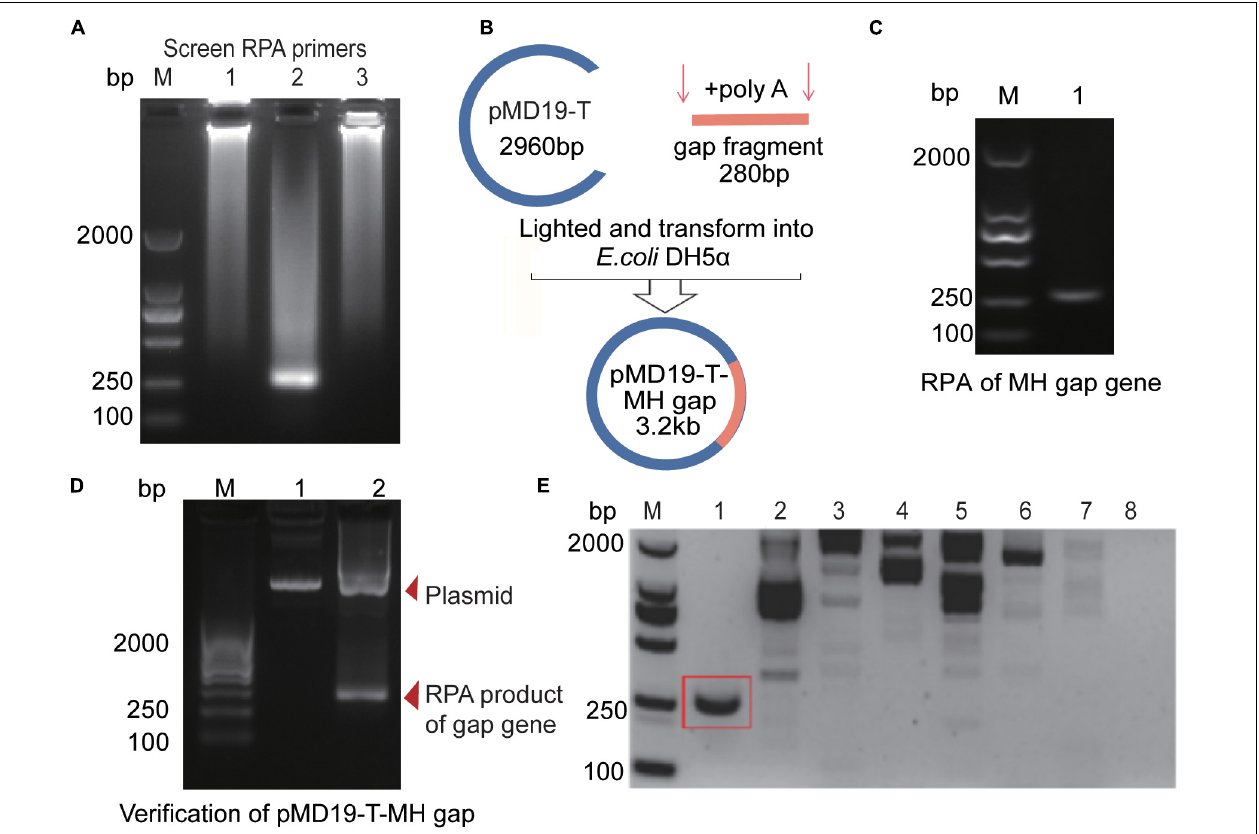
FIGURE 1 | RPA primers optimization and construction of the pMD19-T-MH gap plasmid. (A) Optimization of RPA products of M. hominis target sequences with three different primers. (B) Construction process of recombinant pMD19-T-MH gap with a 280-bp M. hominis gap gene fragment. (C) Agarose gel electrophoresis for detecting RPA products of the gap gene. (D) Agarose gel electrophoresis for detecting the pMD19-T-MH gap (3.2 kb) and the RPA products of the gap gene (280 bp). (E) Agarose gel electrophoresis for detecting RPA products with different microorganisms. 1, M. hominis ; 2, C. albicans ; 3, E. coli ; 4, K. pneumoniae ; 5, S. aureus ; 6, S. flexneri ; 7, S. saprophyticus ; 8, U. urealyticum . bp, base pair; M, marker; MH, M. hominis ; gap, glyceraldehyde-3-phosphate dehydrogenase; RPA, recombinase polymerase